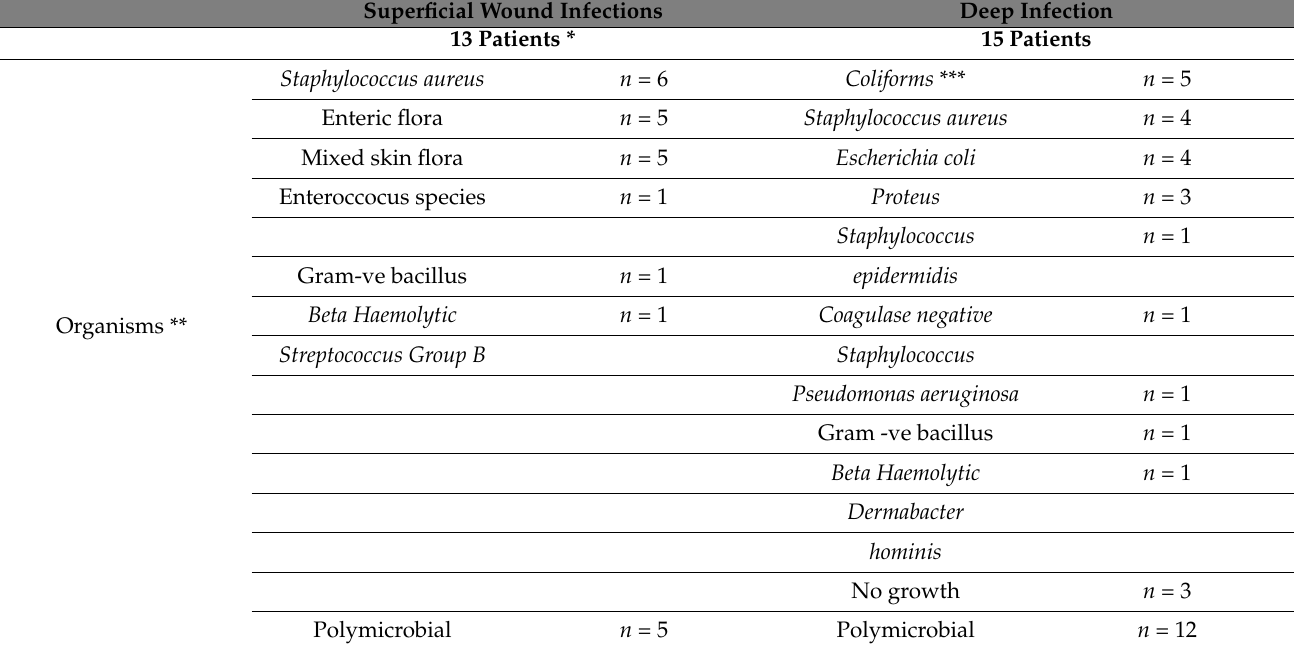
Table 2. Pathogenic micro-organisms for superficial and deep infections. Superficial infections diagnosed according to micro-organisms isolated from the wound swab. Deep infections diagnosed according to micro-organisms isolated from the wound swab and deep tissue